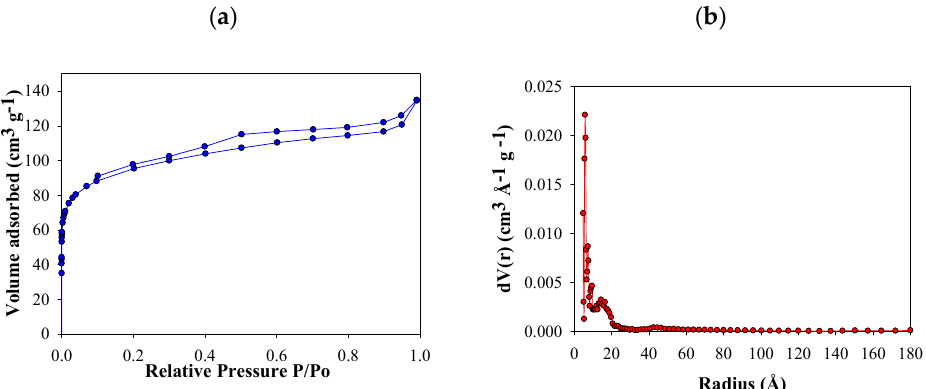
Figure 2. N 2 adsorption–desorption isotherm of FB850-3 ( a ) and pore size distributions by Quenched Solid Density Functional Theory (QSDFT) of FB850-3 ( b ).